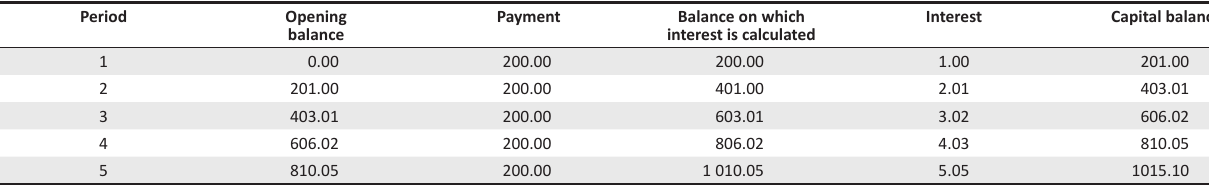
TABLE 1: Annuity payments made at the beginning of the month.